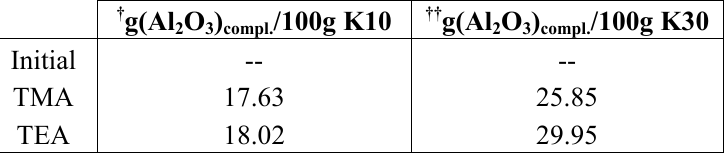
Table 2. Aluminium attached on the commercial MMT obtained by